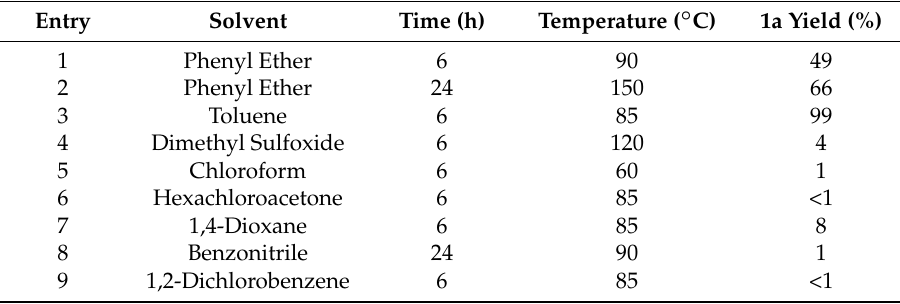
Table 2. Conversion of 1-phenyl ethanol ( 1 ) to acetophenone ( 1a ) in selected solvents. Entry Solvent Time (h) Temperature ( ◦ C) 1a Yield